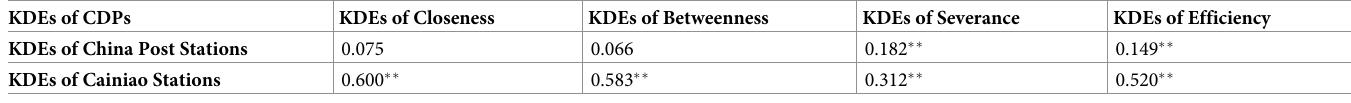
Table 2. Pearson correlation analysis between KDEs of the centralities and KDEs of